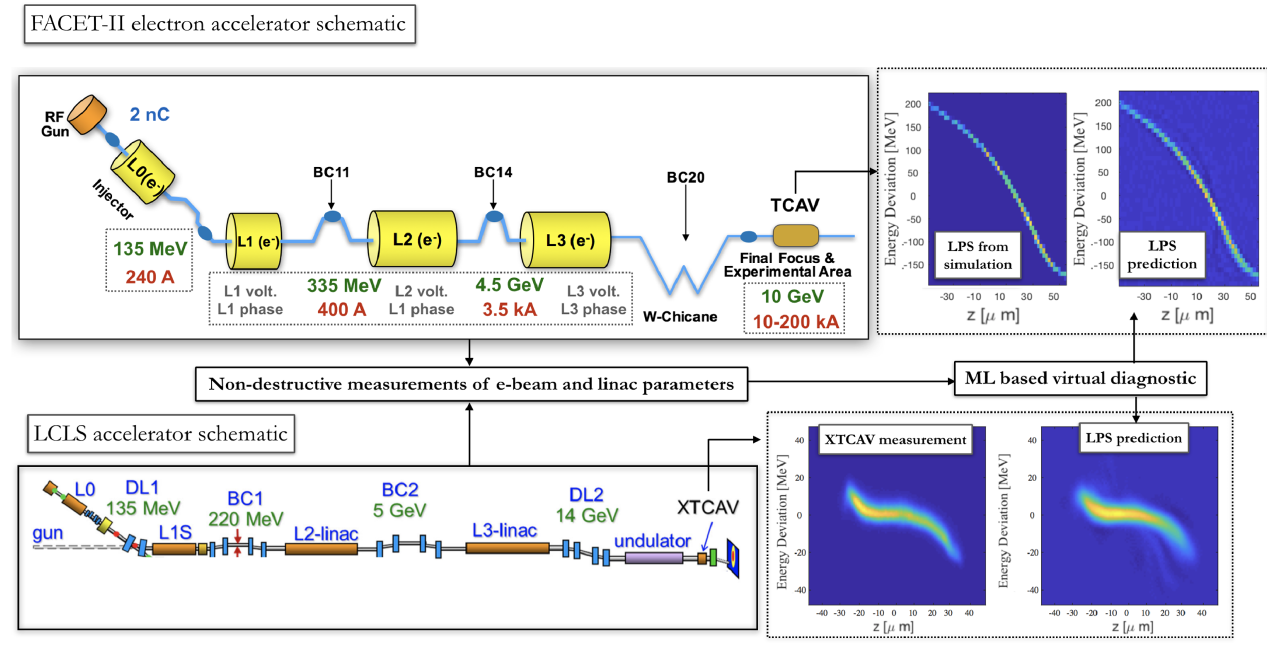
[m]FIG. 1. Schematic of the FACET-II and LCLS electron accelerators and example LPS profiles from particle tracking simulations (FACET-II), experimental measurements (LCLS) and from the ML-based virtual diagnostic predictions. The figure highlights the similarities between the two accelerator layouts up to the BC20 chicane in FACET-II which is used to increase the current from 3 – 4 kA to 10 – 200